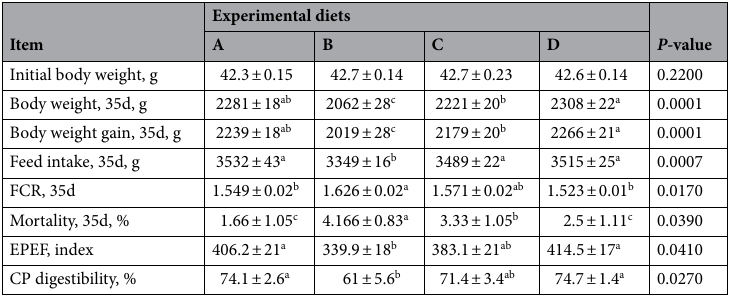
Table 2. Effect of DETOXIZYME supplementation on growth performance under clostridia infection in Cobb 500 broilers. a–c The means values placed at the rows by different superscript letters are significantly different (P < 0.05). Values are expressed as means ± standard error. Abbreviations: (A) control negative (basal diet), (B) control positive (basal diet supplemented with clostridia infection), (C) control positive group diet with 100 g DETOXIZYME/ton of feed, (D) control negative diet group with 100 g DETOXIZYME/ton of feed, (EPEF) European production efficiency factor.